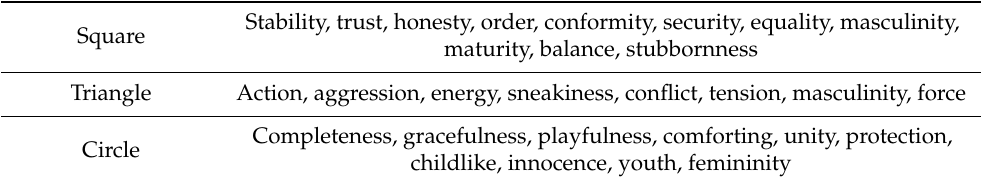
Table 1. Meaning of shapes.